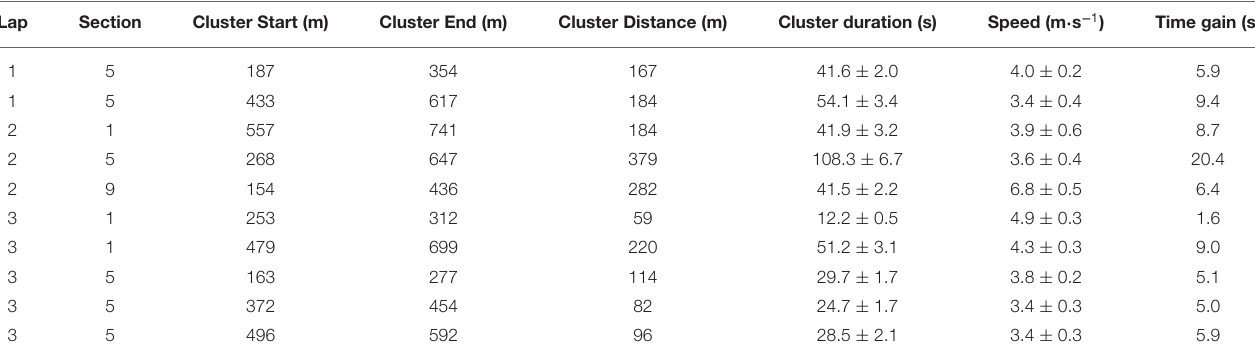
TABLE 4 | Characteristics of the SPM clusters where section time was significantly related to instantaneous speed for the men, with mean ± standard deviation time, velocity, and time gain (i.e., the time difference between the fastest and slowest skier) for each cluster. Lap